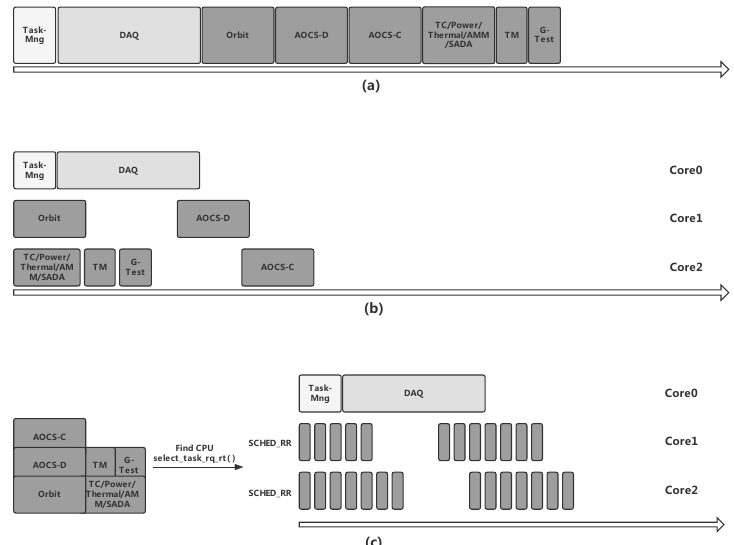
Figure 11. Comparison of scheduling schemes for performance experiment. ( a ) Single-core scheduling scheme. ( b ) Static scheduling scheme. ( c ) Our scheduling